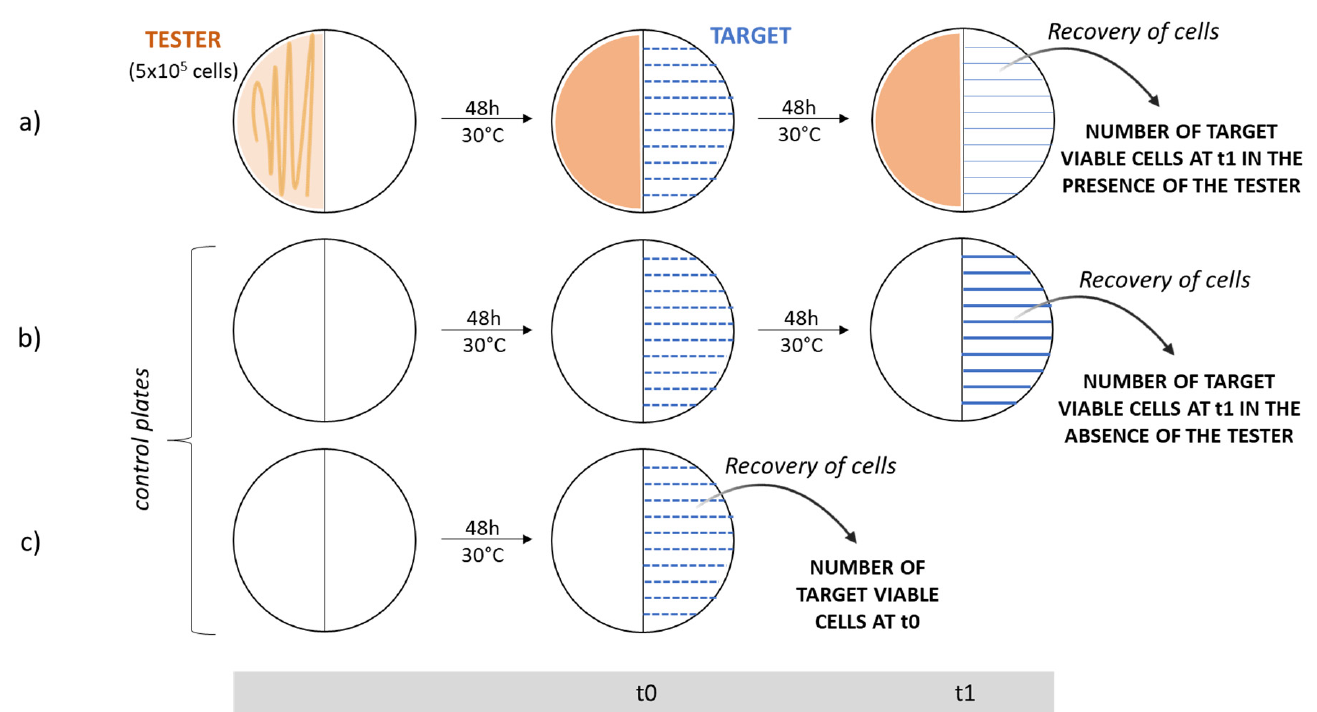
Figure 4. Schematic representation of the quantitative cross-streaking method. Target strain (blue) is streaked 10 times onto 3 half Petri dishes with septum. The cross-streaking plate ( a ) tests the ability of the tester strain (orange) to antagonize the growth of the target, while the growth control plate ( b ) permits one to verify its growth in the absence of the tester. In these last two cases, cells are recovered after incubation for 48 h at 30 °C (t 1 ). The control plate ( c ) allows one to determine the number of cells streaked on the TSA medium; in this case, cells are immediately recovered for the viable count (t 0 ).